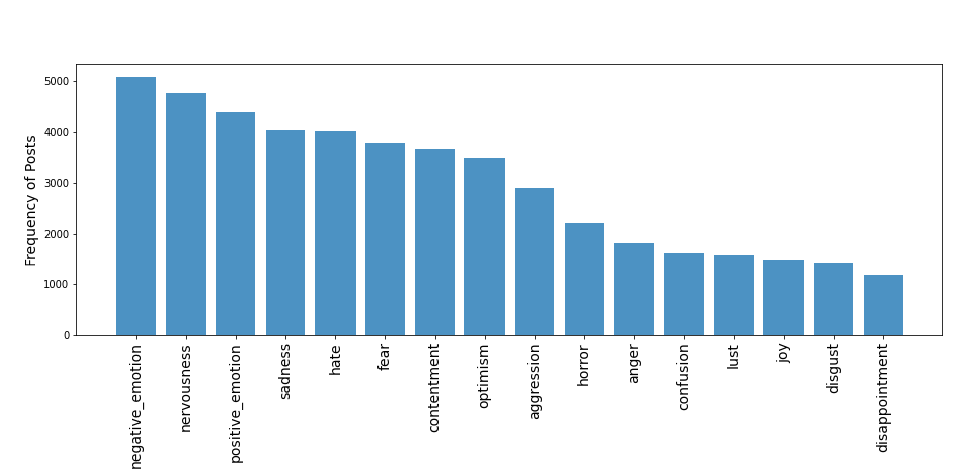
Figure 6 . Frequency of posts having positive scores of empath categories.